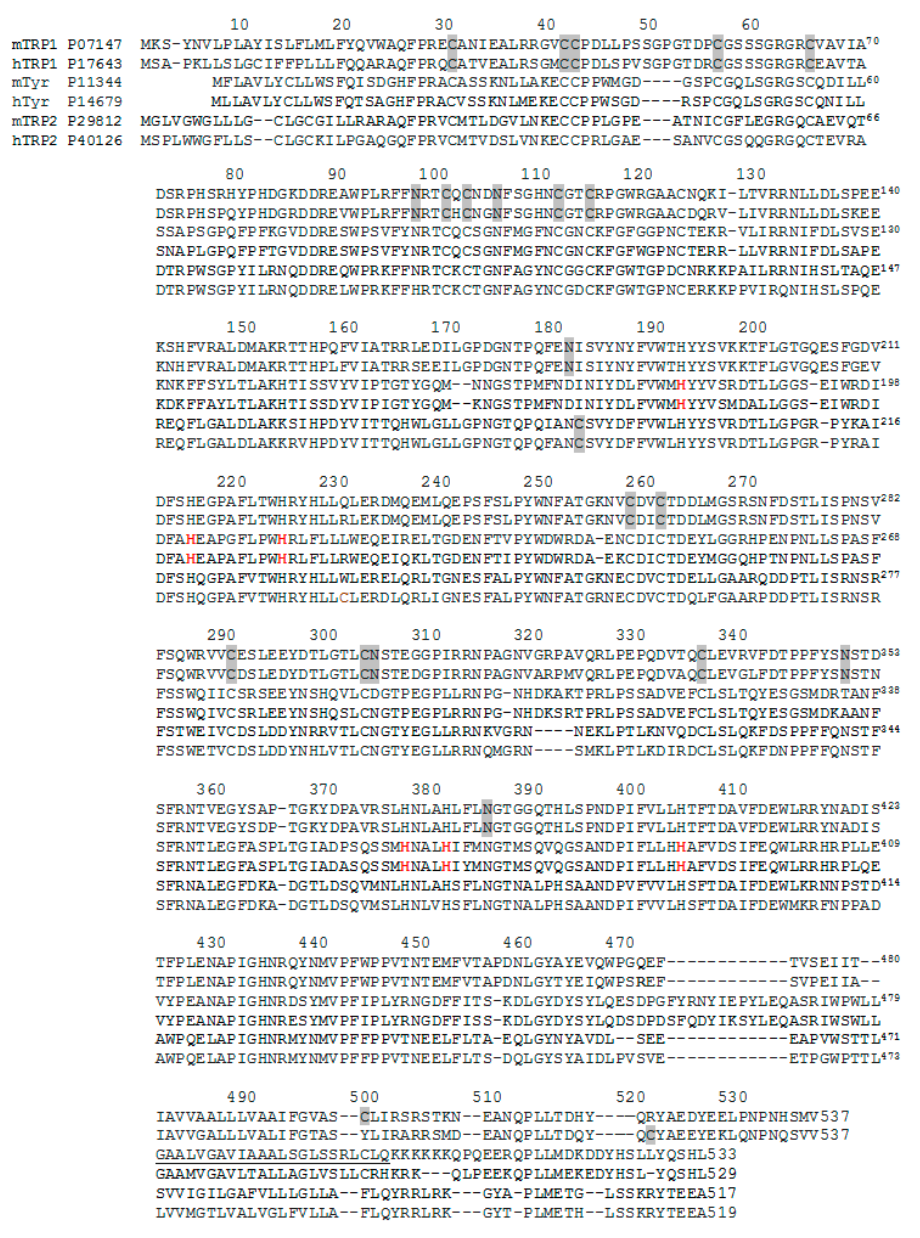
Figure 2. Sequence alignment of mouse (m) and human (h) Trp1 (first two lines), tyrosinase (third and fourth) and Trp2 (fifth and sixth). Alignment was performed with Expasy facilities. References of the six proteins are indicated in the initial line for each one taken from the UniProtKB database (Available online: www.expasy.org, [69]). Important Cys and Asn residues are indicated on Trp1 sequences (grey residues). Conserved His at the MeA and MeB binding sites are marked in bold on the tyrosinase sequence (central lines). The transmembrane fragment is underlined in mouse tyrosinase. For other details and relevant residues, see the